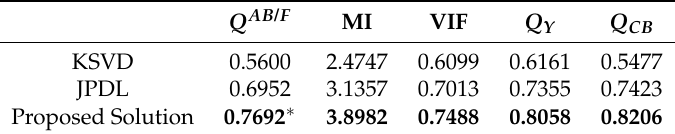
Table 2. Fusion Performance Comparison - 2 of Multi-focus Fluorescence Image Pairs.